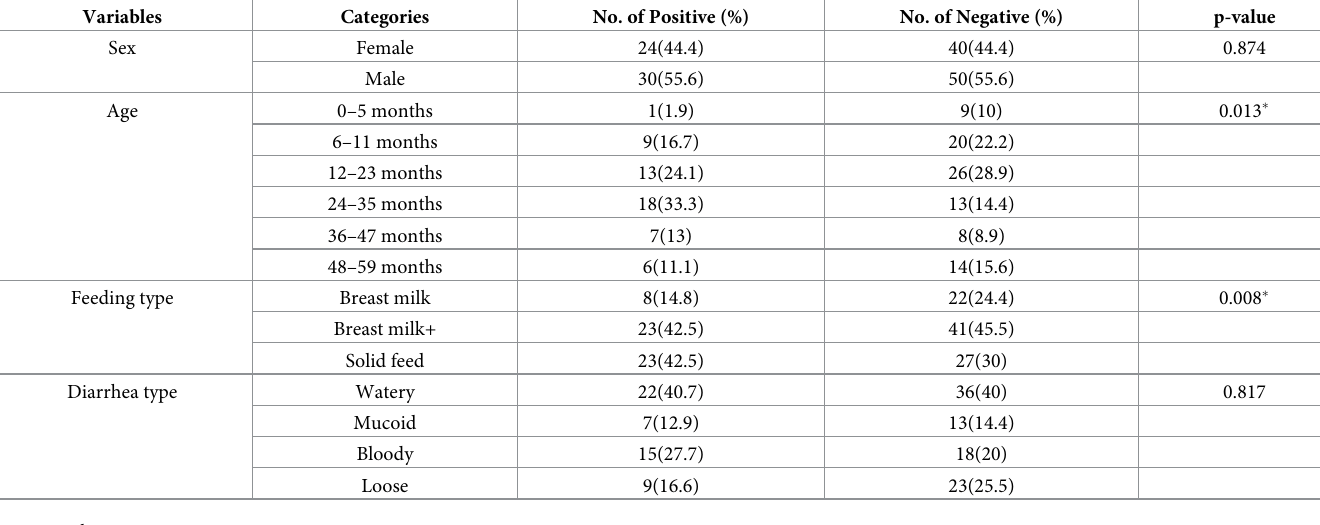
Table 1. Occurrence of E . coli based on age, sex, and clinical features in diarrheic children. Variables